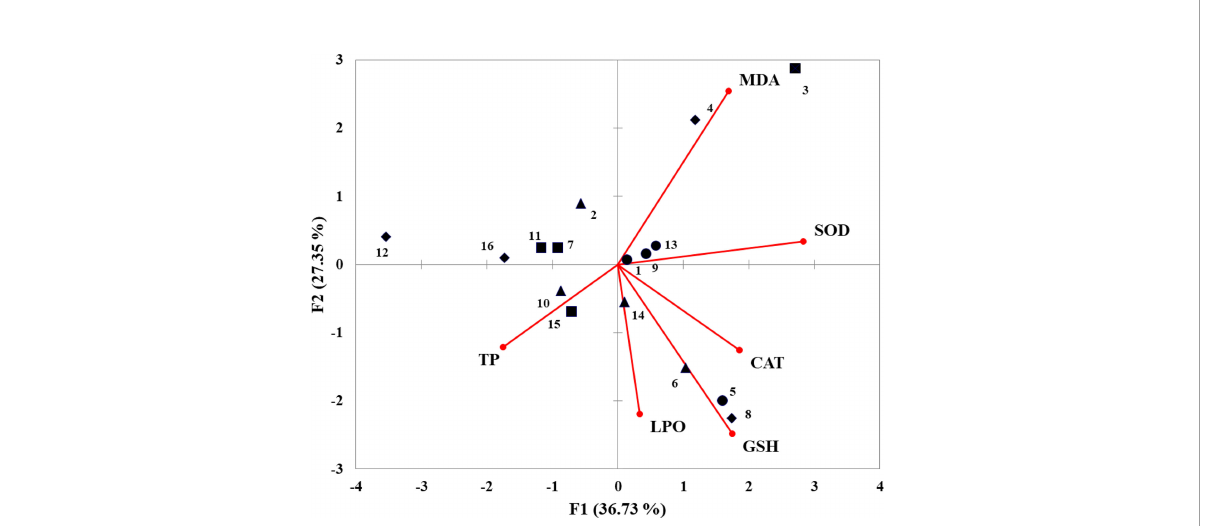
FIGURE 7 Biplot of principal component analysis with all measured variables (TP, SOD, CAT, MDA, GSH, LPO) at fi ve different time points (days 7, 14, 21, and 28) in fi ve different treatments ( ● artemia only with 0 conc., ▲ nano-PS 10 4 particles l -1 conc., ■ Cu 2+ 10 µg l -1 conc., ♦ nano-PS + Cu 2+